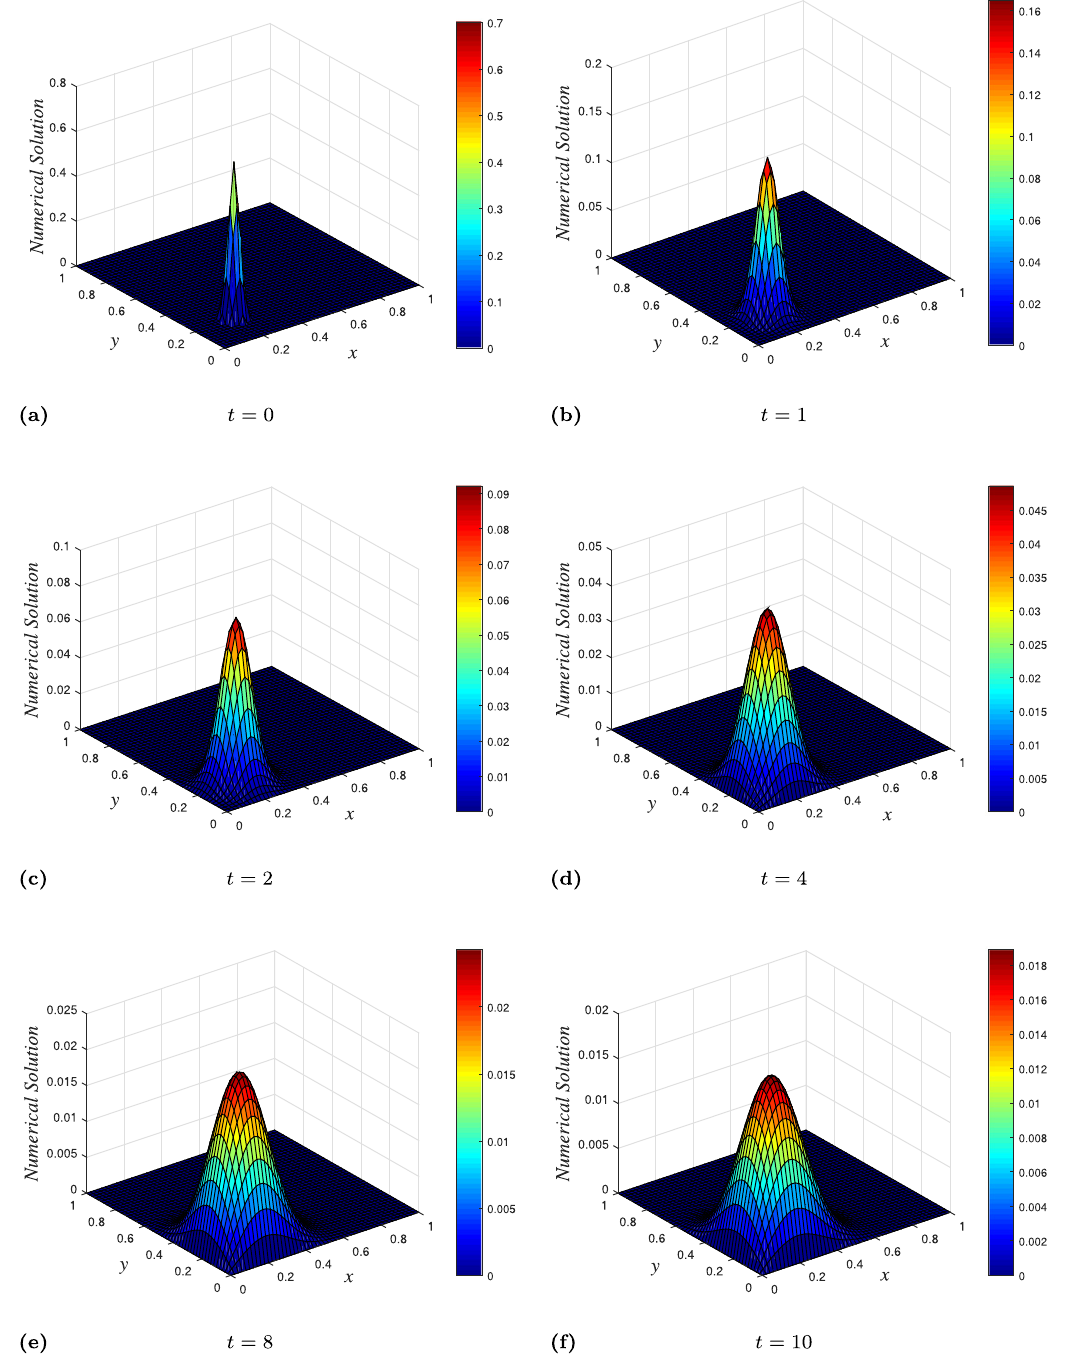
Figure 2: Plot of numerical solution vs x vs y using NSFD scheme at times = t 0, 1, 2, 4, 8 , and 10 . With spatial step sizes = = h h 0.02 x y and time - step = k 0.05 . ( a ) = t 0 . ( b ) = t 1 . ( c ) = t 2 . ( d ) = t 4 . ( e ) = t 8 . ( f ) = t 10